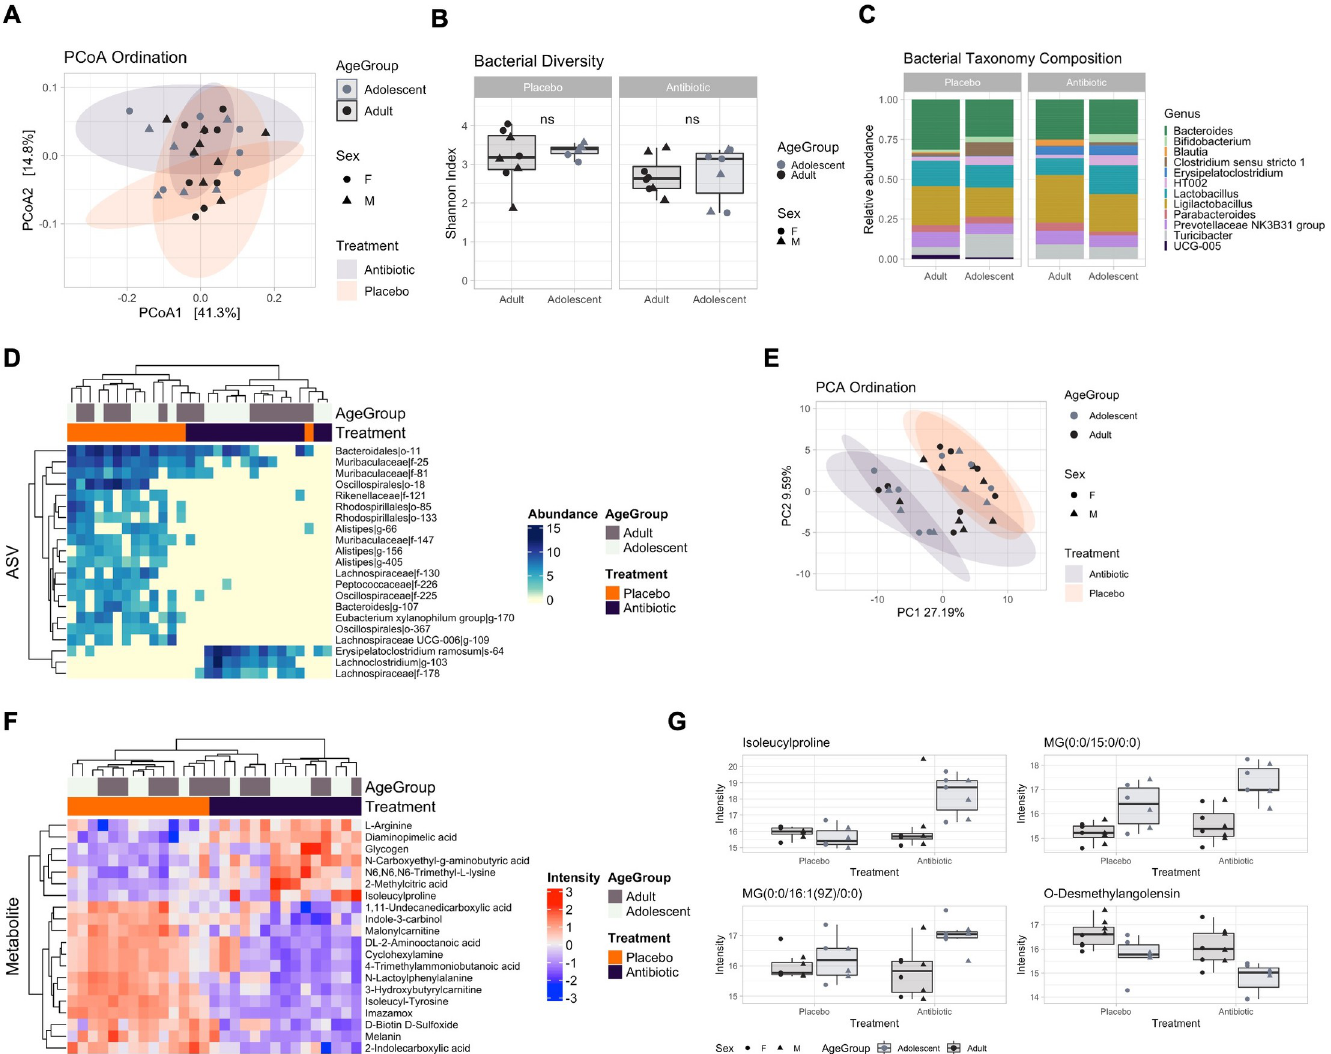
Fig 5. Comparison of antibiotic-treated adolescent and adult microbial and metabolomic profiles. (A) Principal coordinate analysis (PCoA) showing bacterial ordination by age group and treatment at day 30. (B) Bacterial Shannon diversity boxplots, and (C) Taxonomy composition barplots, comparing treatment and age groups at day 30. (D) Heatmap of differentially abundant ASVs between treatment groups at day 30. (E) Principal component analysis (PCA) showing metabolomic ordination by age group and treatment at day 30. (F) Heatmap of differentially abundant metabolites between treatment groups at day 30. (G) Boxplots of differentially abundant metabolites between age groups at day 30. Boxplots are indicative of median, interquartile range (IQR) (boxes) and 1.5x IQR (whiskers). n.s., not significant.